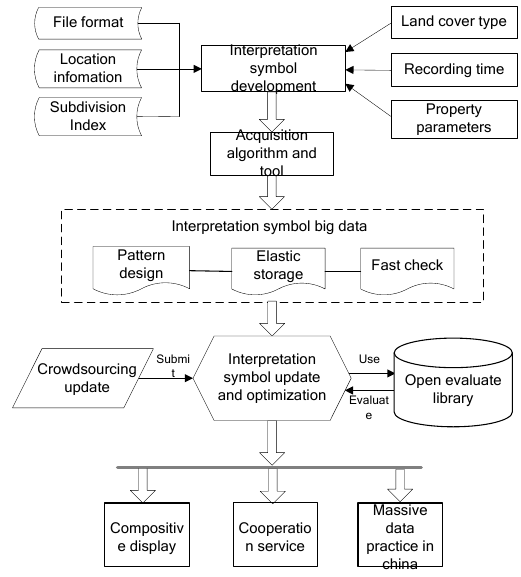
Figure 2. The workflow of RSAIS big data construction in